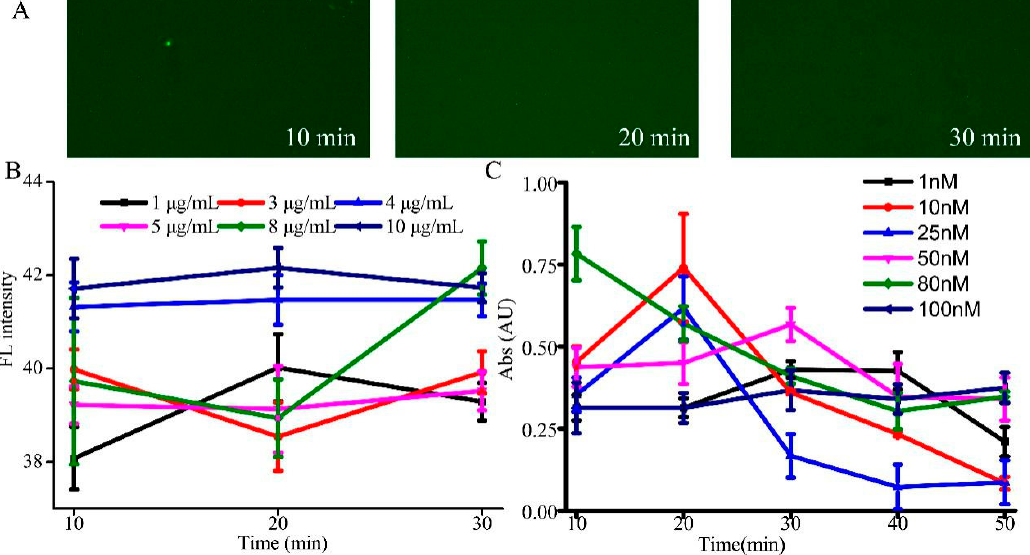
Figure 2. ( A ) Fluorescent images of 10 μ g/mL SA coating on the microwell with different time; ( B ) Optimization of streptavidin coating time; ( C ) Optimization of FNAs conditions.